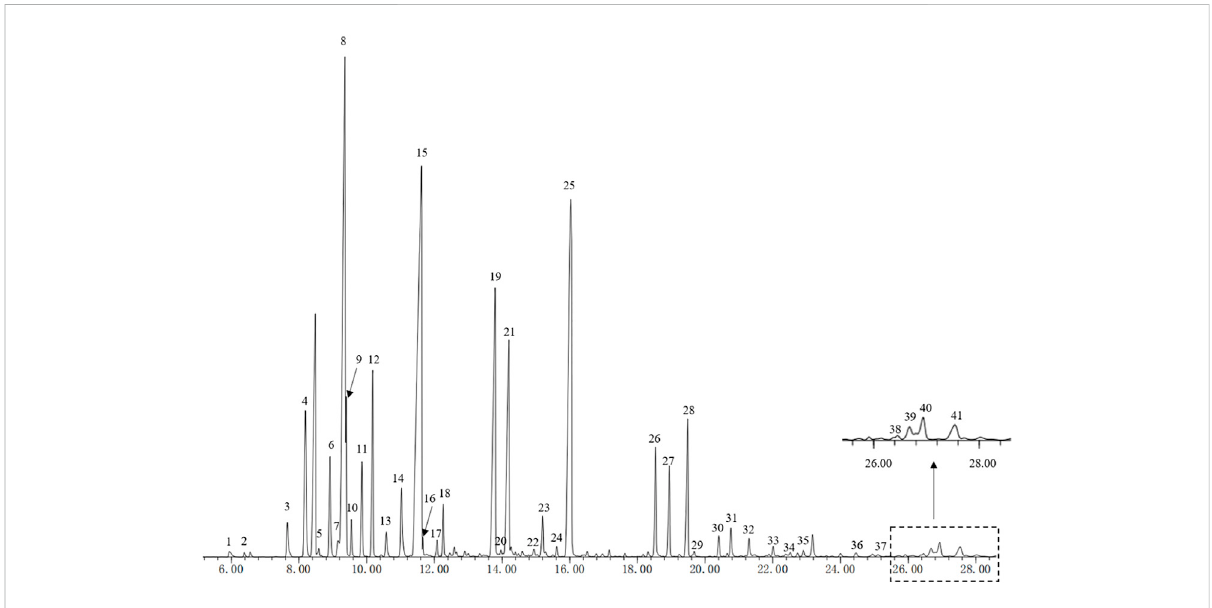
FIGURE 1 GC-MS detected 41 peaks (Relative Content > 0.1%) of HEO. HEO, the essential oil from the fruits of Z. bungeanum Maxim.; GC-MS, Gas chromatography-mass